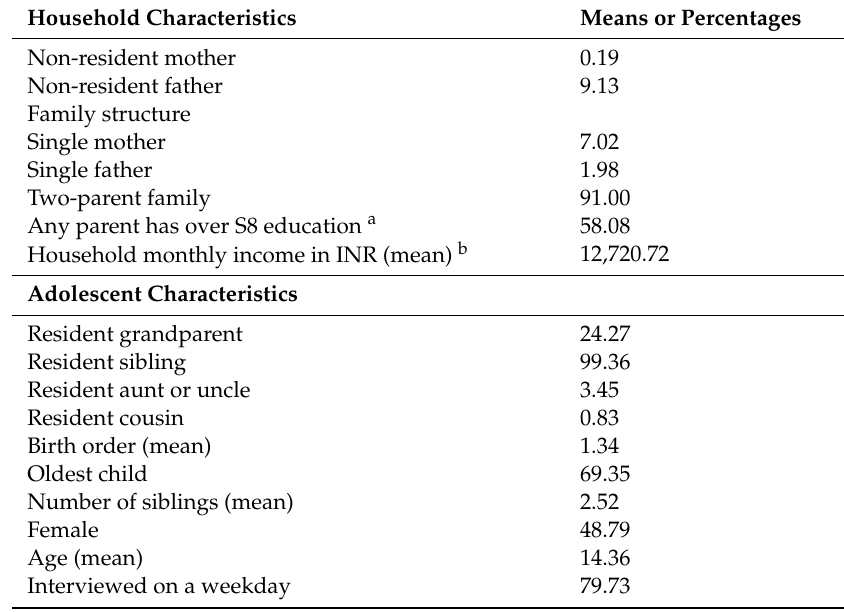
Table 1. Descriptive Statistics (Means and Percentages) for Adolescents, Tamil Nadu, India ( n = 1568